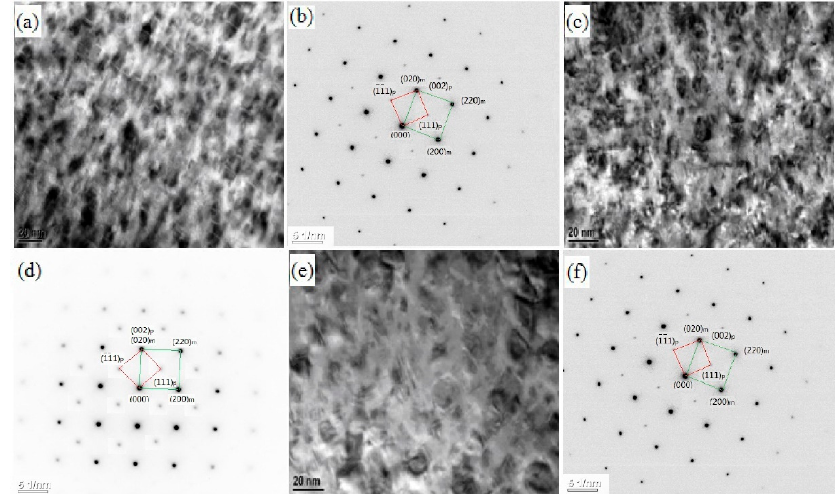
Figure 7. TEM of alloy aged at 500 °C for 4 hours with a zone axis of [001] Cu : ( a ) Bright image of the S2 alloy. ( b ) SADP of ( a ) ( c ) Bright image of the S3 alloy. ( d ) SADP of ( c ) ( e ) Bright image of the S4 alloy. ( f ) SADP of ( e ).